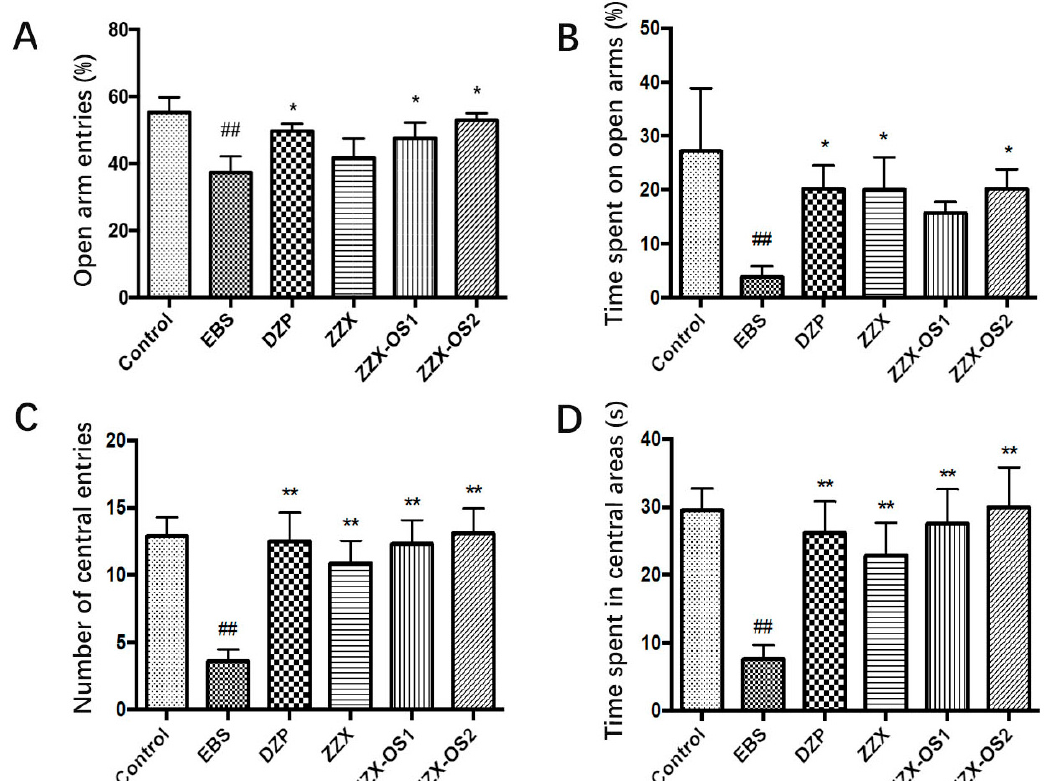
Figure 2. Comparison of the anxiolytic effect of the two optimal solutions (OSs) and ethanol extract of ZZX. ( A ) Open-arm entries (OE%). ( B ) Time spent in the open arms (OT%) ( n = 6–8). ( C ) Number of central entries. ( D ) Time spent in central areas. ( n = 10; mean ± SEM. ## p < 0.01 vs. Control; * p < 0.05, ** p < 0.01 vs. EBS).